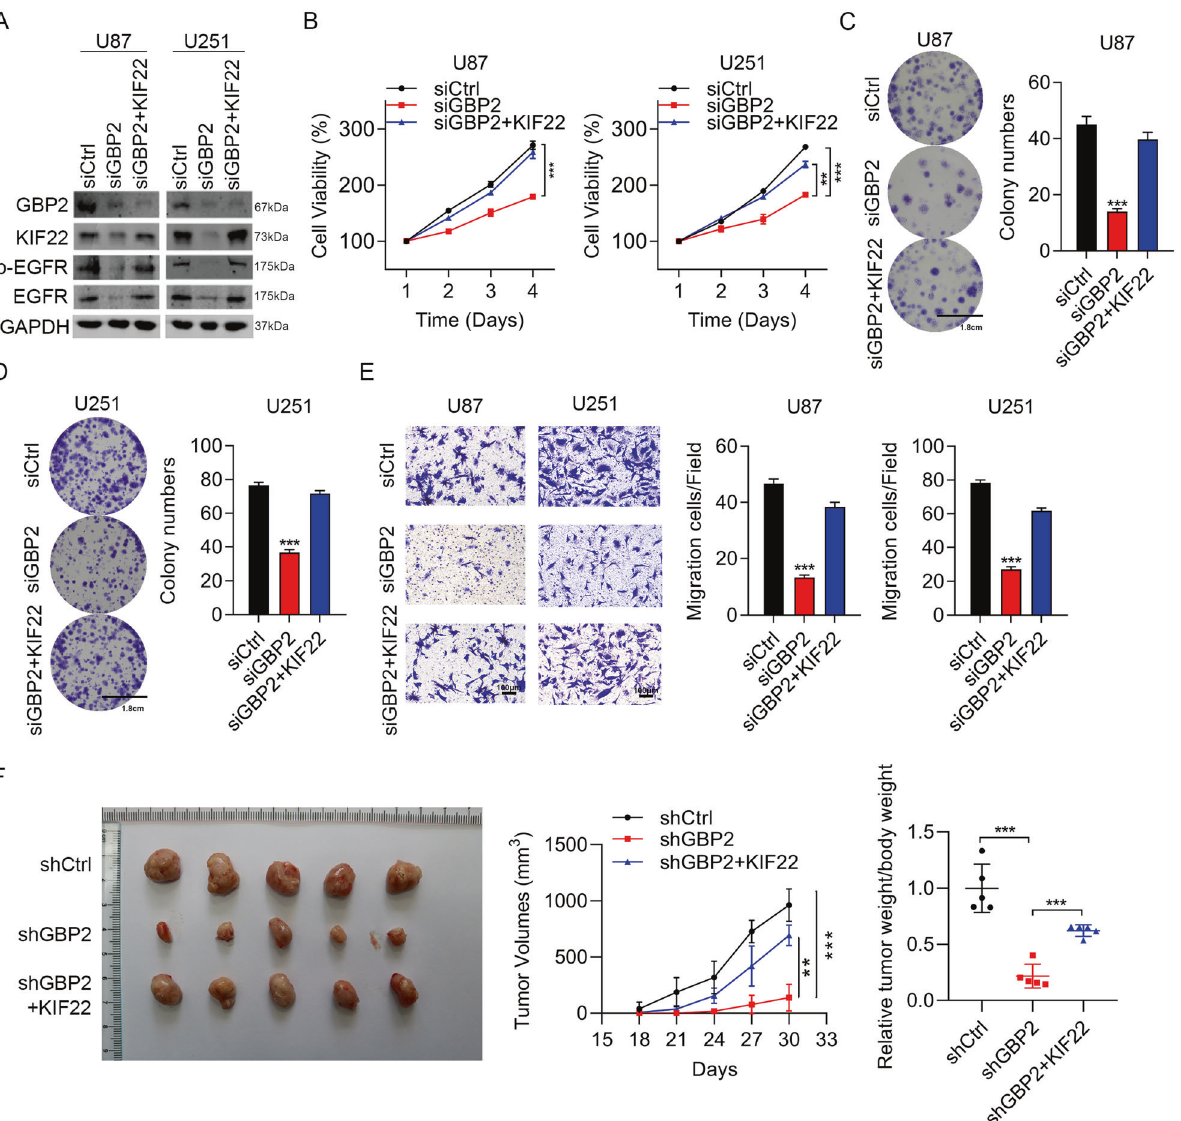
U251 cells transfected with siCtrl, siGBP2, or siGBP2 + KIF22. F U87 cells exogenously expressed shCtrl, shGBP2, and shGBP2 + KIF22 were injected into athymic nude mice ( n = 5), and tumor formation was analyzed. Representative images and weight of xenografted tumors are shown. Each experiment repeated as least 3 times. Magni fi cation: ×10. ** P < 0.01, *** P <